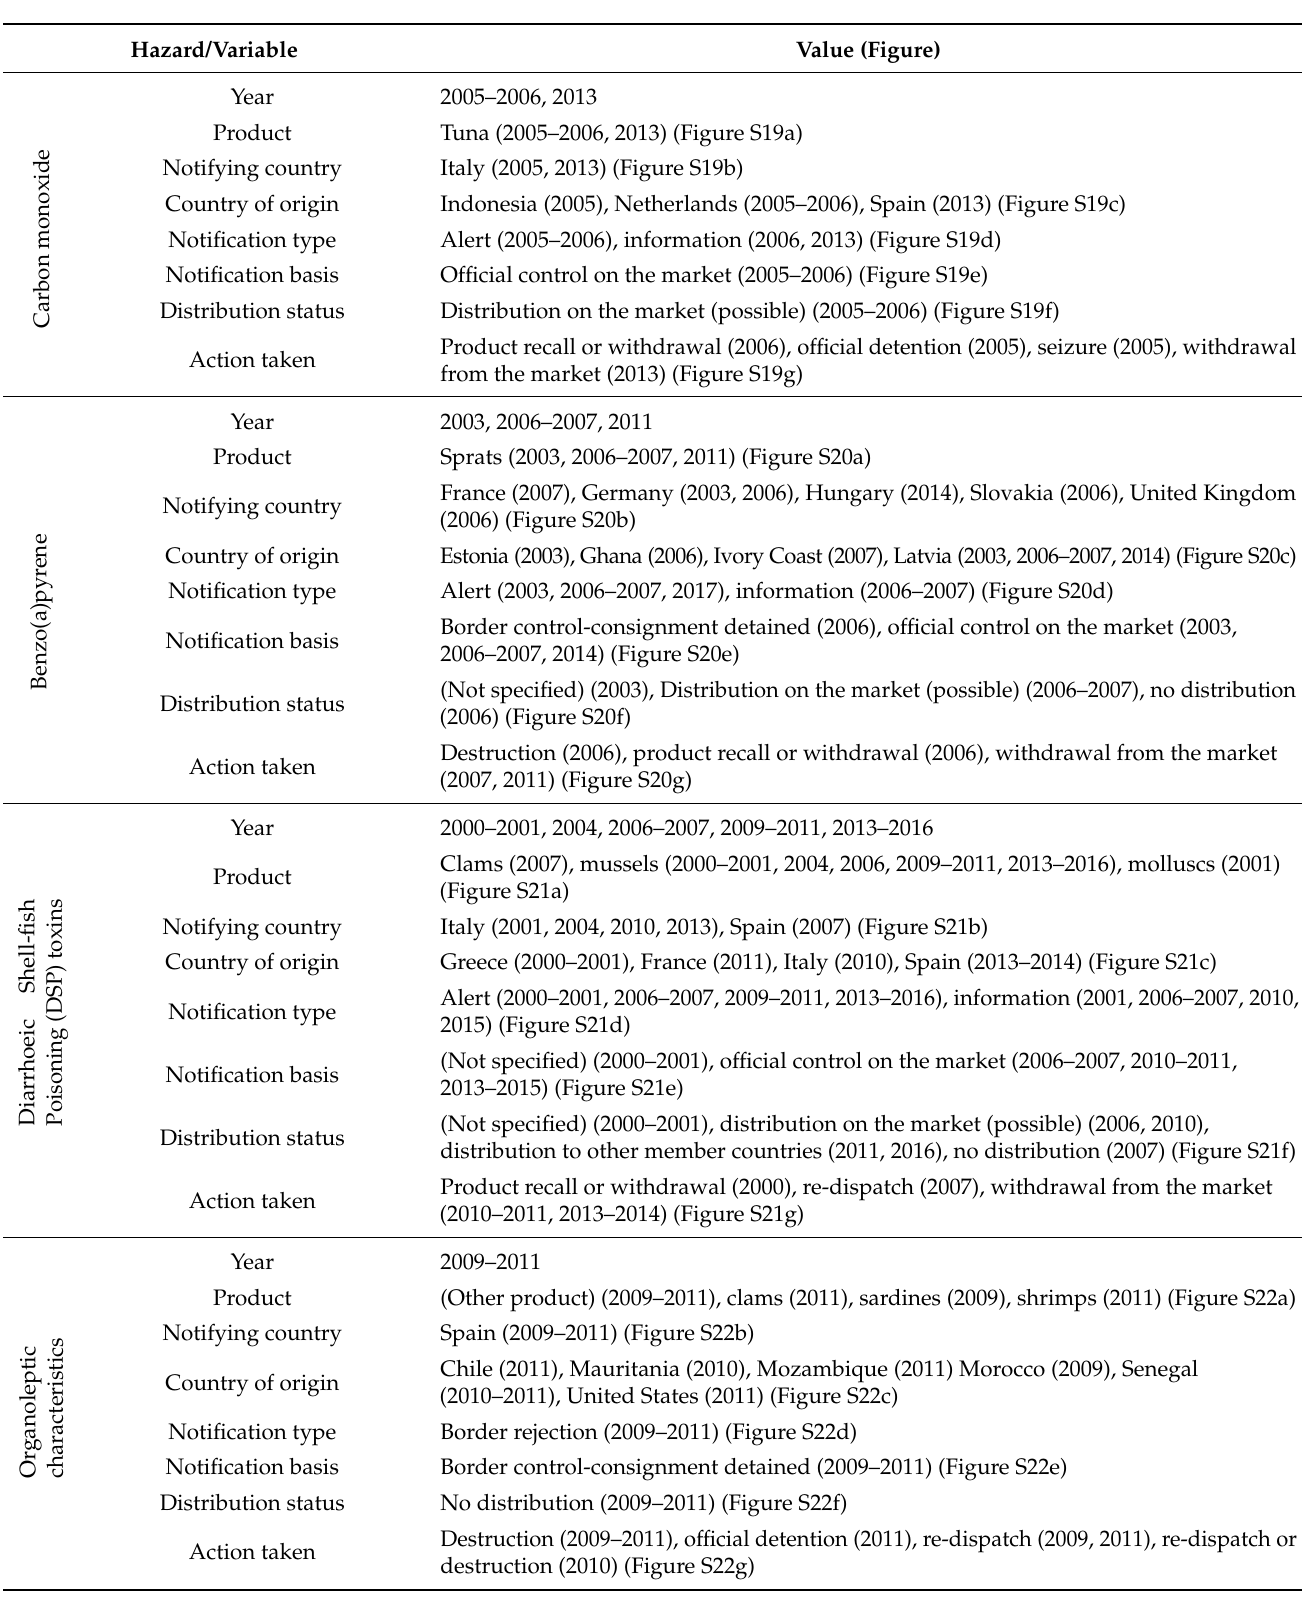
Table 11. Results of two-way joining cluster analysis related to other hazards above 100 notifications in seafood in the RASFF in